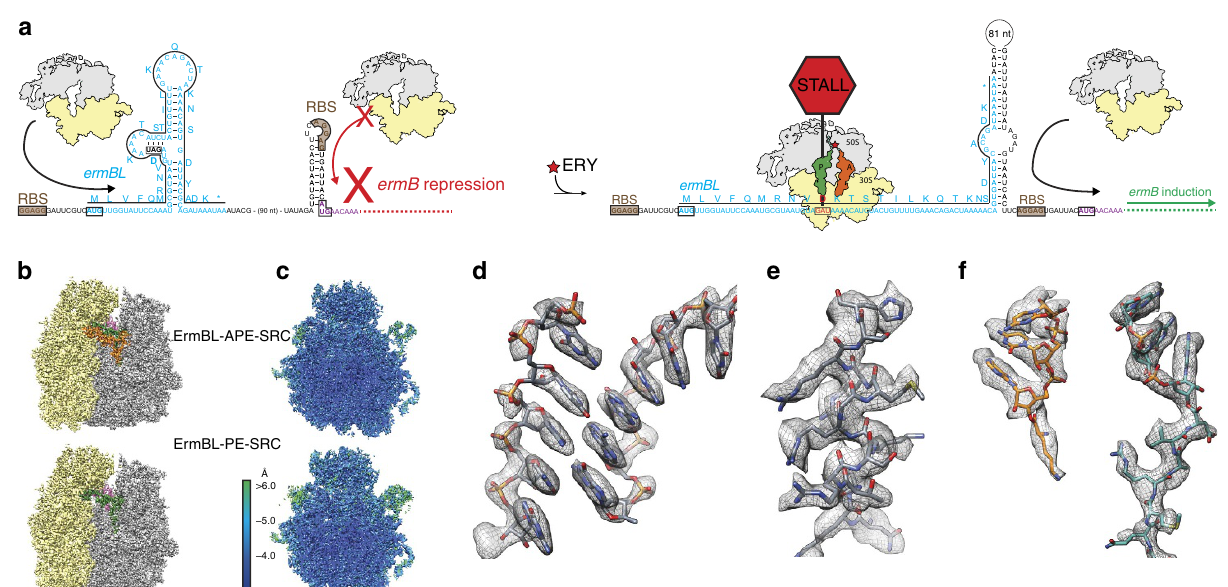
Figure 1 | Cryo-EM structure of the ErmBL-SRC. ( a ) Schematic for ermBL -dependent regulation of ermB translation in the presence of ERY. ( b ) Cryo-EM maps of the ErmBL-APE-SRC and ErmBL-PE-SRC, with 30S (yellow), 50S (grey), A-tRNA (orange), P-tRNA (green) and E-tRNA (magenta). ( c ) Transverse sections of the cryo-EM maps of the ErmBL-APE-SRC and ErmBL-PE-SRC, coloured according to local resolution. ( d – f ) Examples of electron density (grey mesh) of the ErmBL-APE-SRC map illustrating ( d ) base separation within an rRNA helix, ( e ) side chains of ribosomal protein a -helix and ( f ) aminoacylated-CCA end of the A-tRNA (orange) and ErmBL peptide attached to the CCA end of the P-tRNA